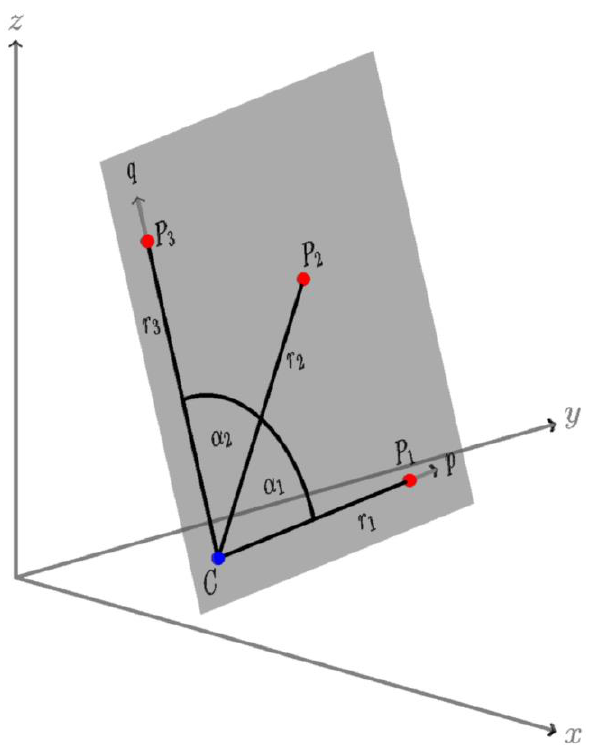
Figure 6. Mathematical model representing the geometry of the new multi-prism platform.